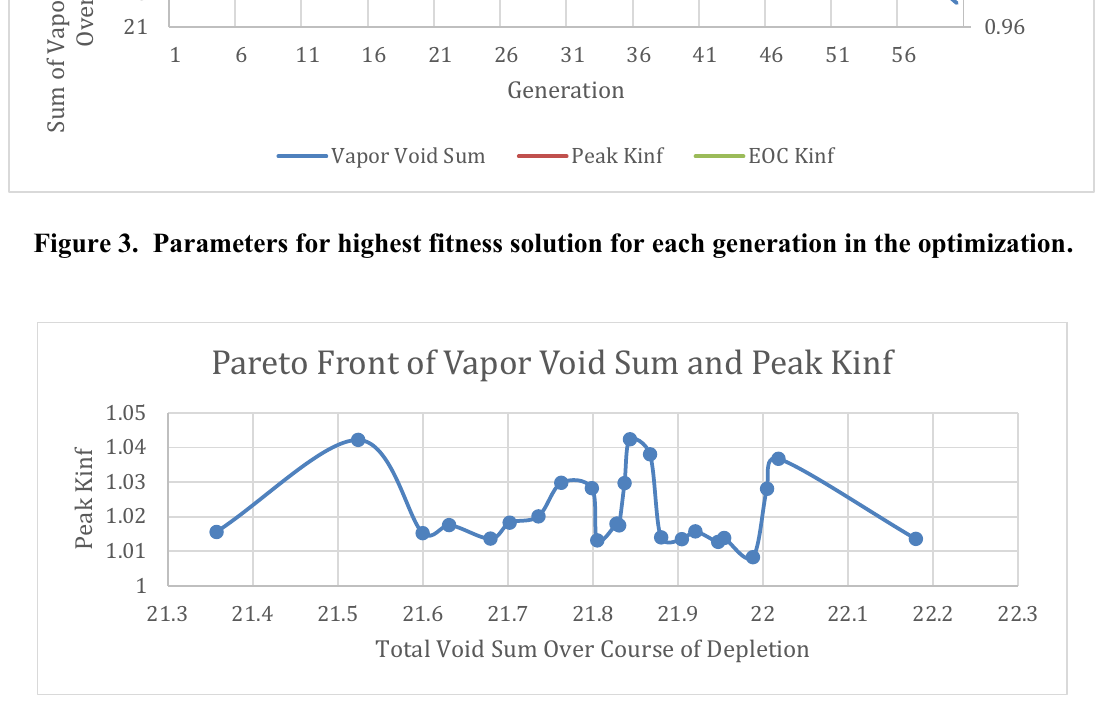
Figure 4. Pareto front vapor void sum verses peak kinf in final solution